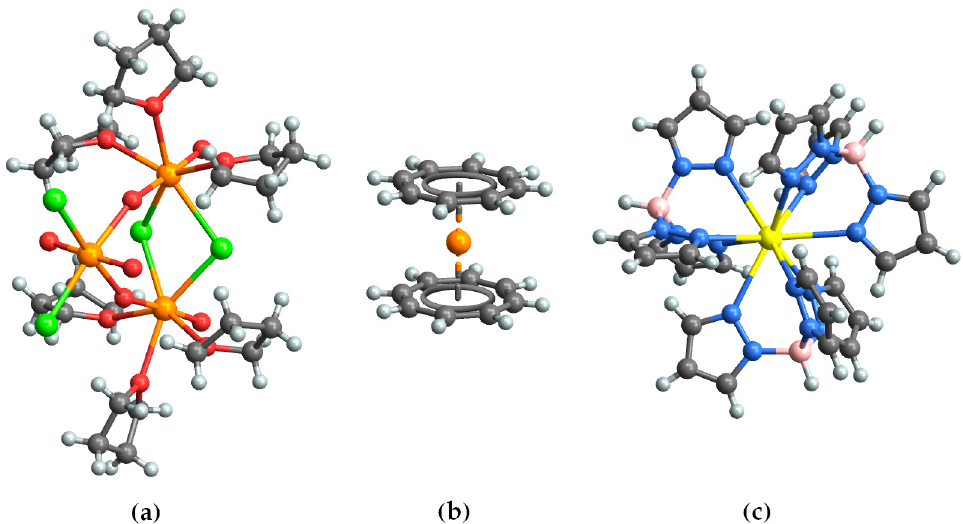
Figure 1. Ball-and-stick structural representation of the three transuranic SMMs reported in the literature so far: ( a ) Np 3 ; ( b ) Np(COT) 2 ; and ( c ) PuTp 3 . The color scheme used for labeling atoms is the following: light gray = H, pink = B, dark gray = C, blue = N, red = O, green = Cl, orange = Np, yellow = Pu.